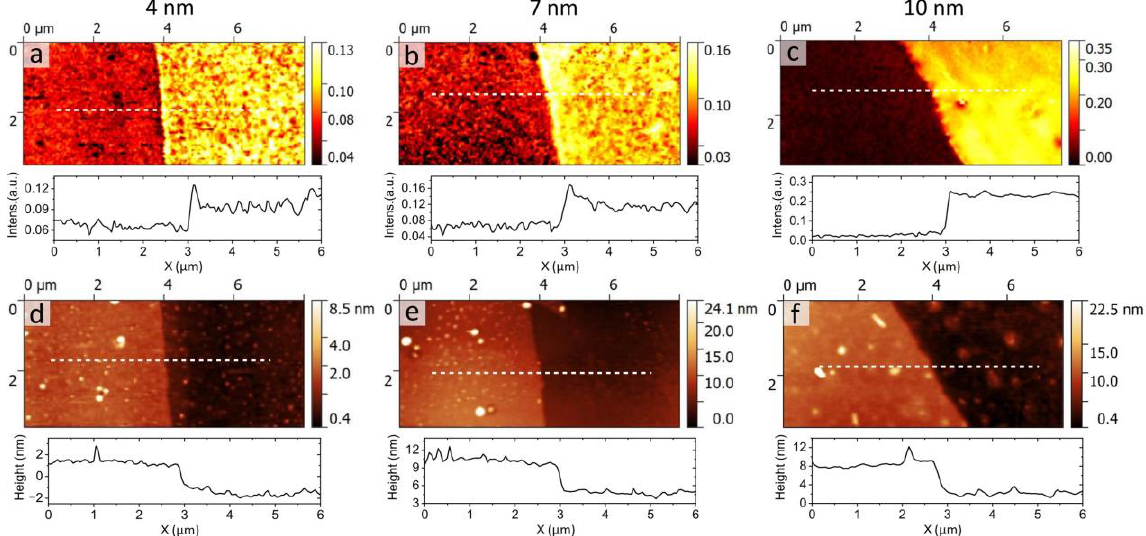
Figure 3. The measured s-SNOM amplitude scans ( a – c ) across the boundary between Au/SiO 2 and Au/MoS 2 areas for three different thicknesses with the intensity of signal cross-sections, related to the dotted white line, in arbitrary units below and corresponding scans of AFM topography ( d – f ) with height profiles below.